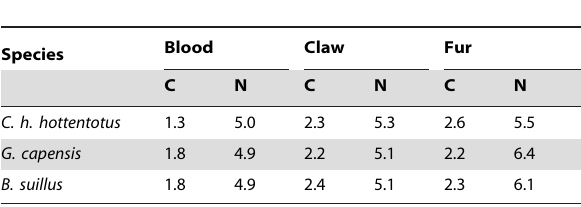
Table 1. Discrimination values used to correct stable isotope